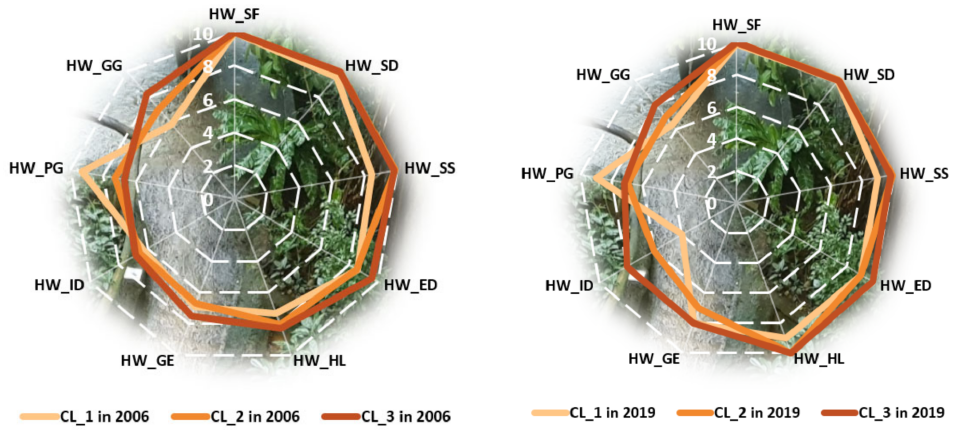
Figure 3. Comparison between clusters regarding human wellbeing components in 2006 vs. 2019. Source: SSI database, computed in Microsoft Excel